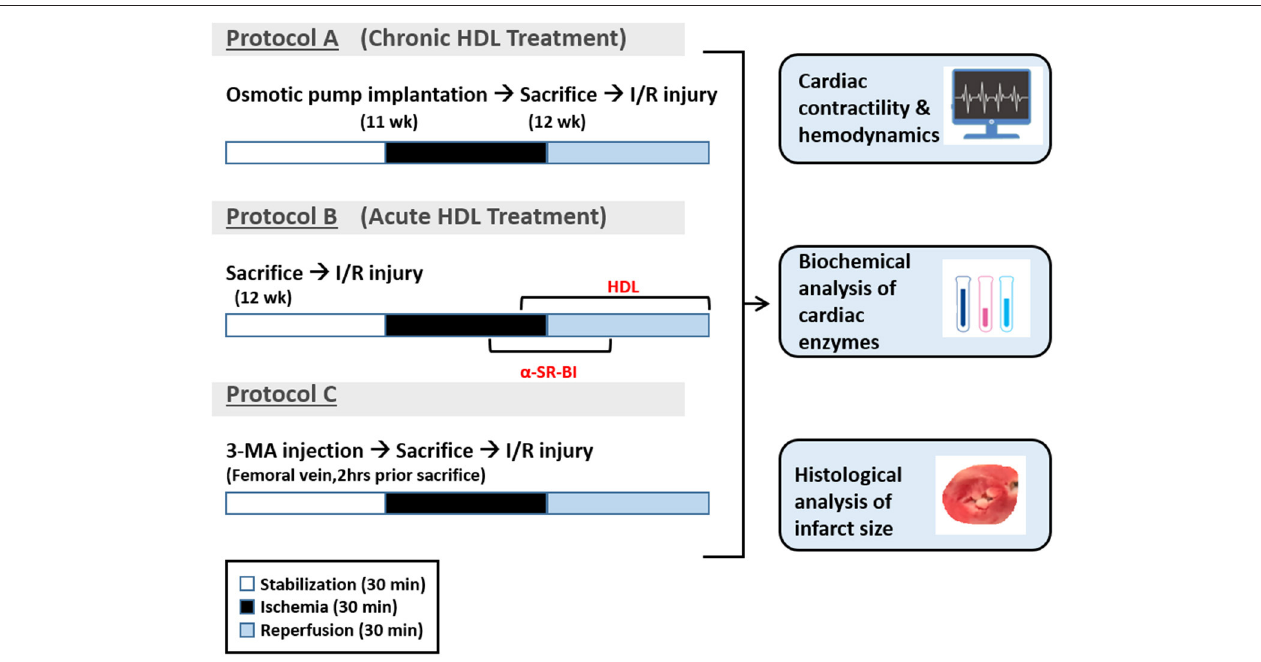
FIGURE 1 | Experimental protocols used in the study. Eleven week old WKY and SHR were implanted with vehicle control or HDL containing osmotic pumps. One week later, rats were sacrificed and subjected to ischemia/reperfusion injury (I/R) with 30min of stabilization followed by 30min of ischemia and 30min of reperfusion (protocol A). A group of untreated WKY and SHR were sacrificed and subjected to I/R injury. SR-BI blocking antibody was administered at 20min of ischemia. Ten minutes later, hearts were perfused with HDL (400 µ g) in the presence of SR-BI blocking antibody for the remaining of the 30min the reperfusion period (protocol B). Another group of untreated WKY and SHR were injected with 3-MA (30 mg/Kg) into the femoral vein. Two hours later, rats were sacrificed and subjected to 30min of ischemia followed by 30min of reperfusion (protocol